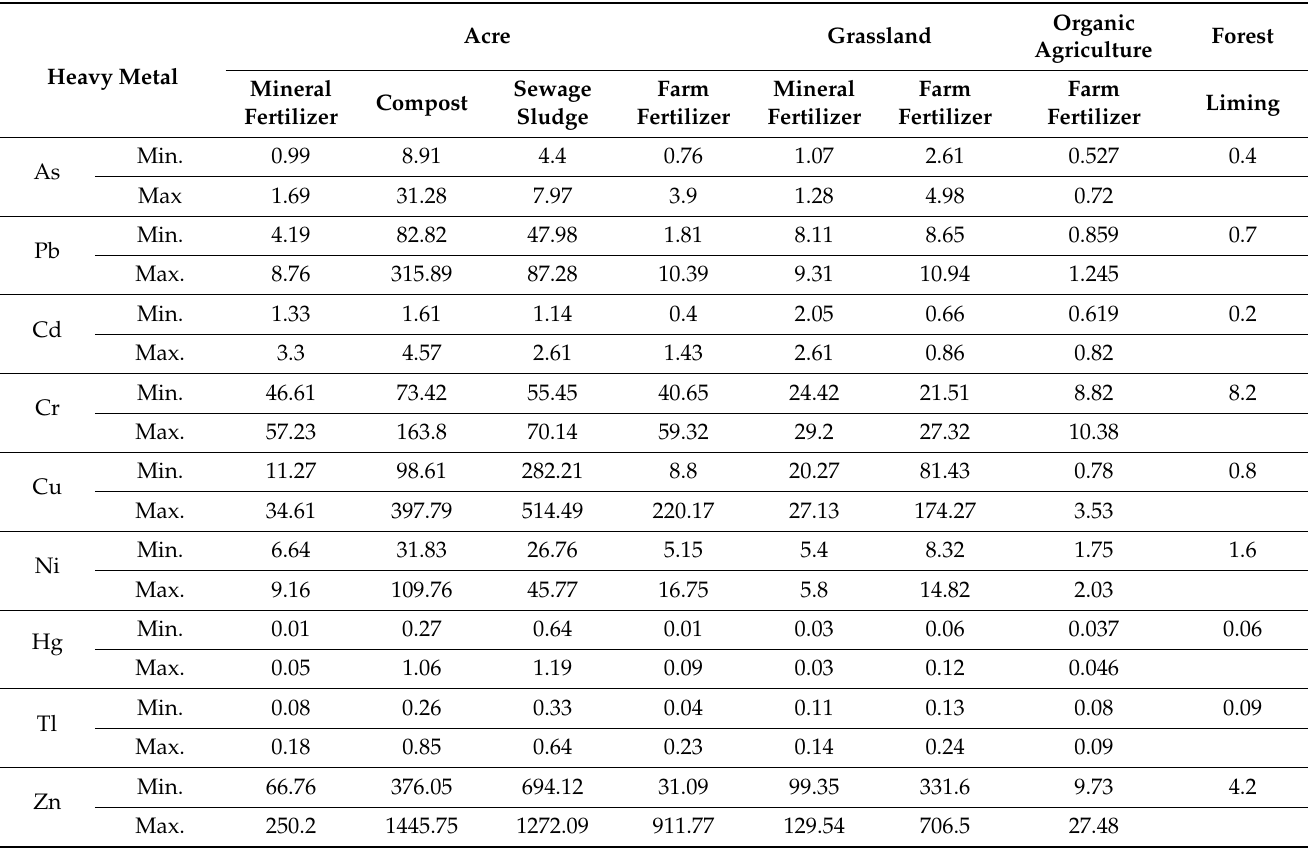
Table 5. HM inputs from fertilisation in agriculture and forestry (in g ha − 1 a − 1 ) in Germany [44].